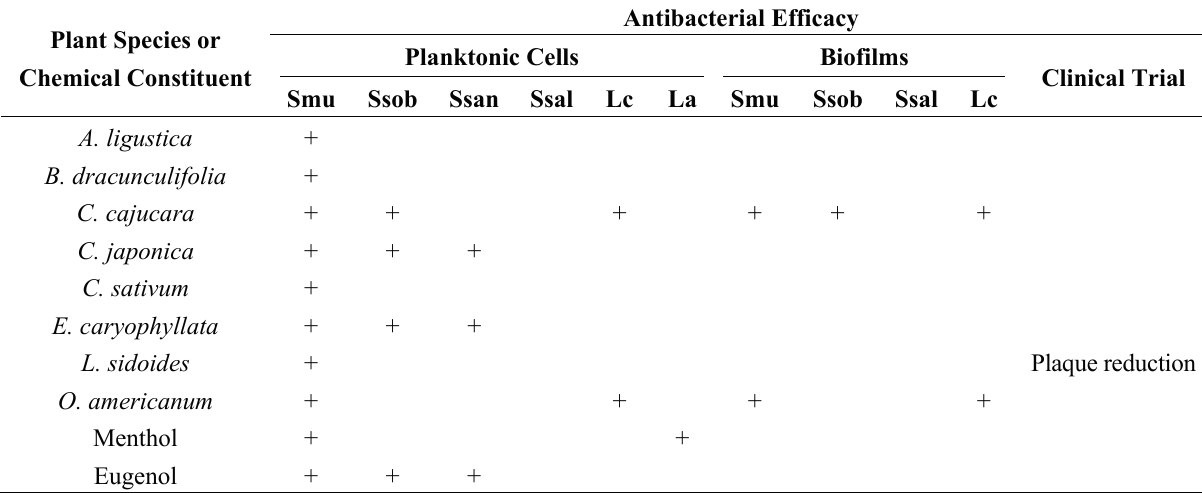
Table 8. Framework of studies. Distribution of promising EOs and their isolated constituents tested against caries-related bacteria.